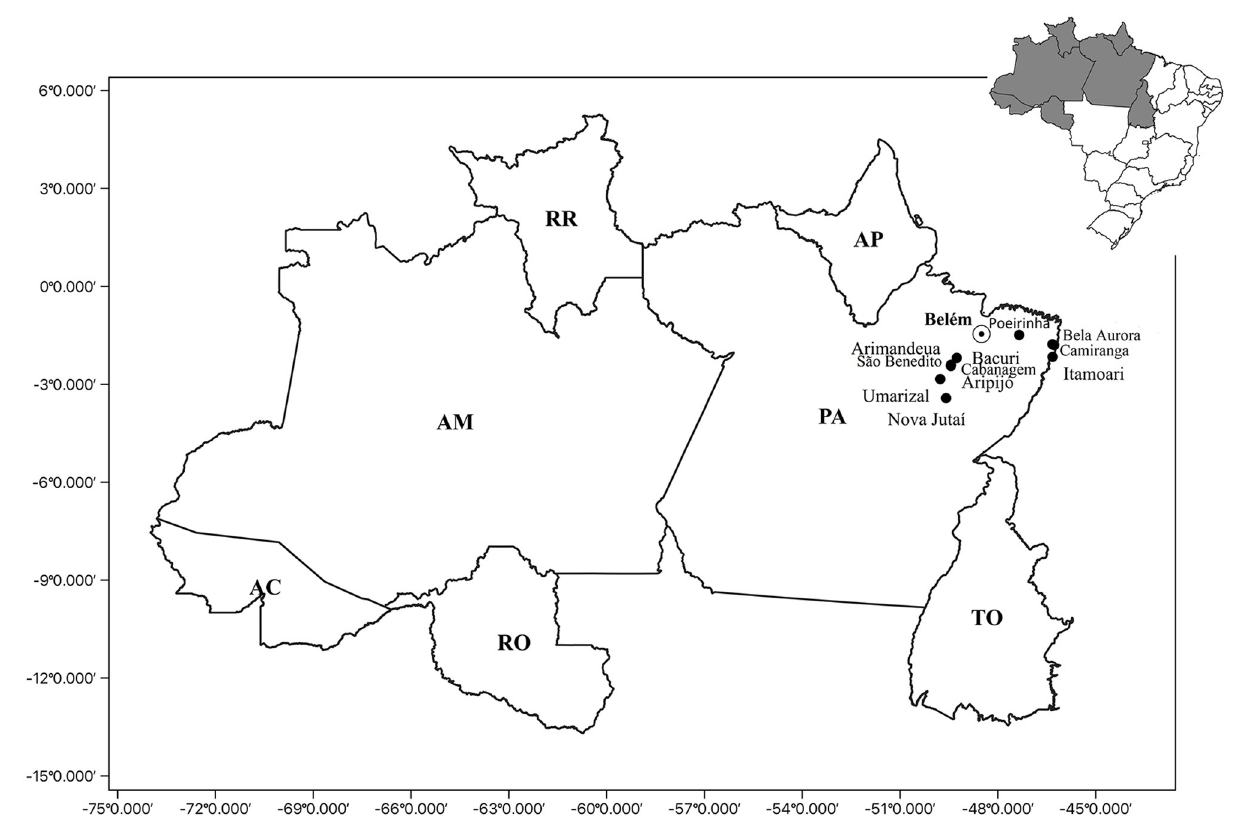
FIGURE 1 | Geographic location of the quilombolas communities: Poeirinha, municipality of Bonito; Bela Aurora, Camiranga and Itamoari, municipality of Cachoeira do Piriá; Arimandeua, Aripijó Bacuri, Cabanagem, and São Benedito, municipality of Cametá; Umarizal Beira, municipality of Baião; and Nova Jutaí, municipality of Breu Branco. PA, Para State; Belém, capital of the Para State; AP, Amapá State; TO, Tocantins State; RR, Roramia State; AM, Amazonas State; AC, Acre State; RO, Rondônia